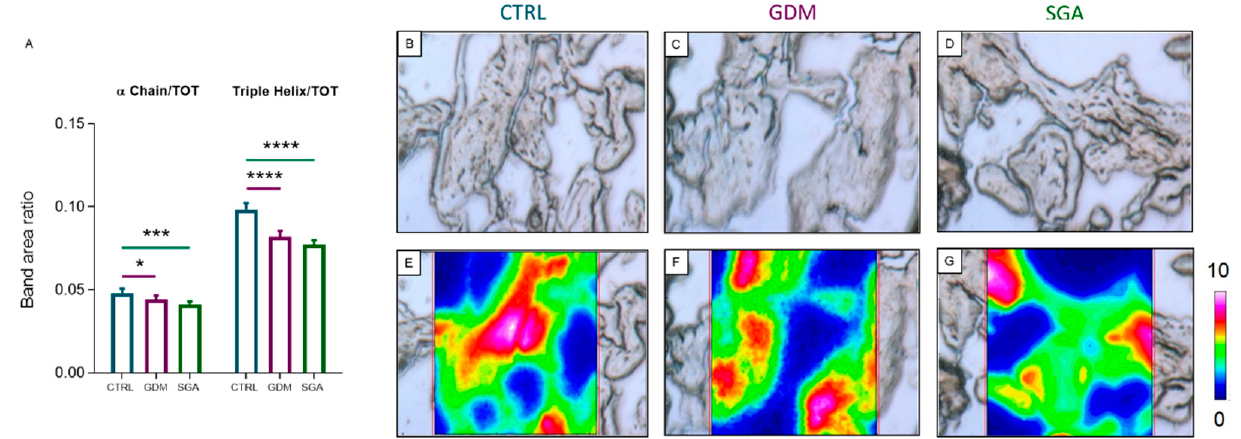
Figure 5. FTIRI analysis of collagen structure in CV sections of CTRL, GDM, and SGA experimental groups. ( A ) Statistical analysis of the following band area ratios: α Chain/TOT (relative amount of α chain secondary structures in collagen) and Triple Helix/TOT (relative amount of triple helix structures in collagen). TOT was the sum of the areas of all the peaks in the 1350–1000 cm − 1 range. Values are reported as mean ± SD of five independent samples ( n = 5). Asterisks indicate significant differences between CTRL and GDM and CTRL and SGA groups (* = p < 0.05, *** = p < 0.001, and **** = p < 0.0001). ( B – D ) Microphotographs of representative sections of CTRL, GDM, and SGA groups, and ( E – G ) corresponding false-color images showing the topographical distribution of collagen within the mapped areas; absorbances ranged from white/pink (representing the highest values) to blue/black (representing the lowest ones). CTRL: control group (blue), GDM: gestational diabetes mellitus (purple), SGA: small-for-gestational-age (green). 2.5. The Carbohydrate Content Is Increased in the CVs of GDM Placentae FTIRI analysis was performed to quantify the amount of carbohydrates in the placental CVs (Figure 8A–G): an increase was found only when comparing GDM to CTRL ( p = 0.0221, n = 5), while no changes were found between SGA and CTRL ( p = 0.2726, n =